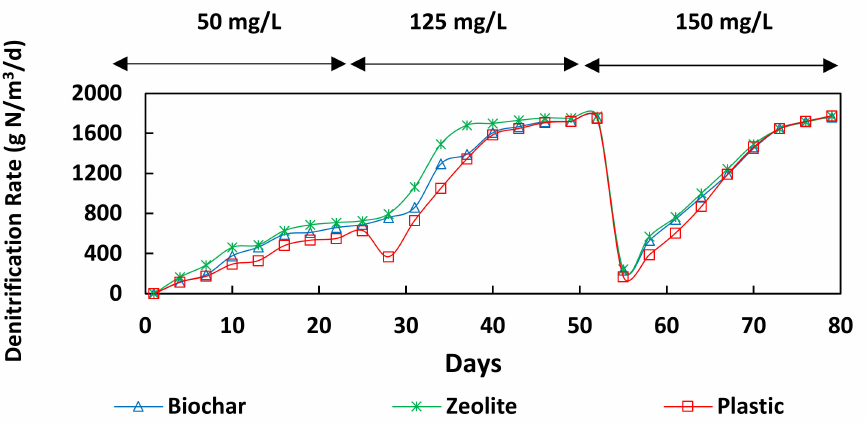
Figure 5. The denitrification rates of the three types of media for the three concentration levels of NO 3